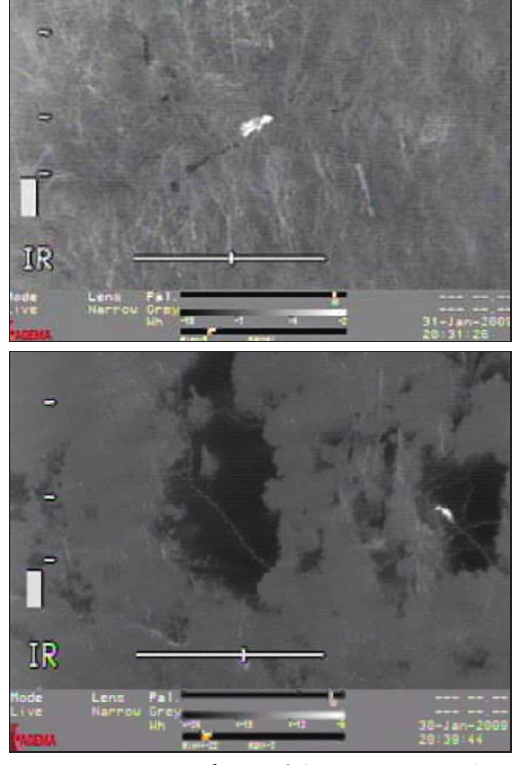
Fig. 3. FLIR images of (a) an adult moose near Marathon, Ontario, taken at an altitude of 610 m (2000 ft) a.g.l. and (b) an adult caribou on the west side of Patterson Island taken at an altitude of 305 m (1000 ft) a.g.l. Even at higher altitude, the moose is obviously much larger and has greater lumi- nous intensity than the caribou. Images courtesy of Susan Bernatas, Vision Air Research, Boise, ID,